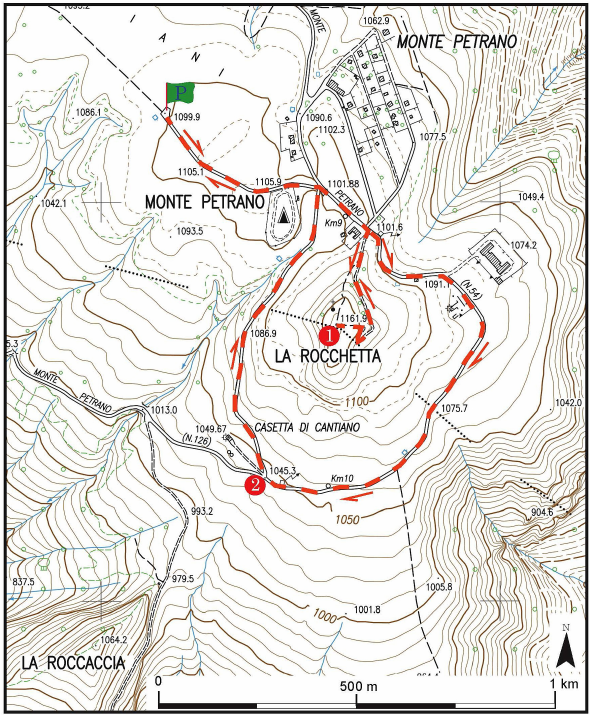
Figure 9. The proposed itinerary at the top of Mount Petrano. Note: P – parking area; 1 and 2 – stop. © 2020 Marche